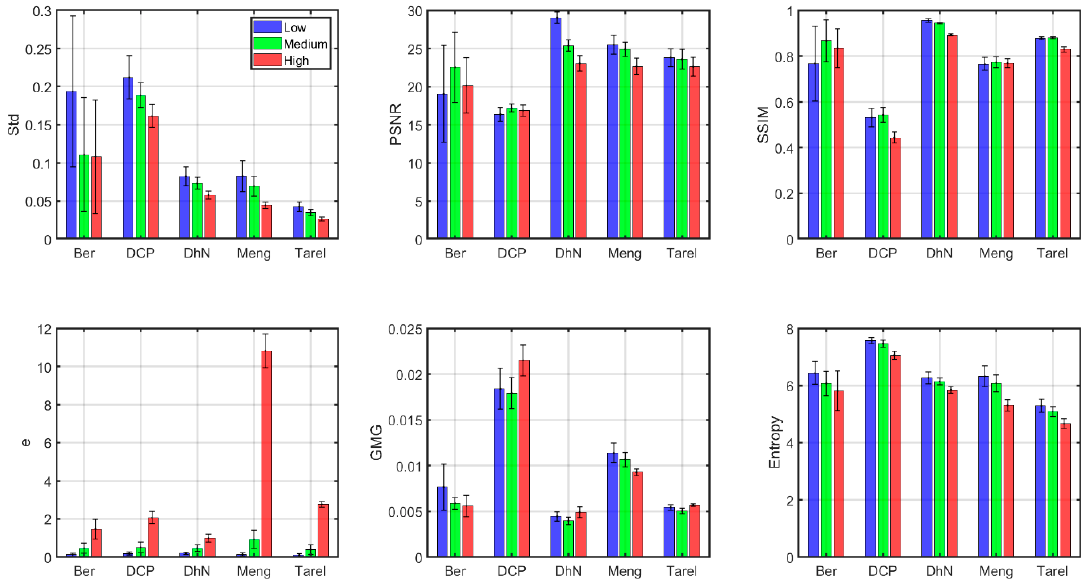
Figure 7. Quality metrics for the dehazed images (average of all wavelengths above 550 nm). Standard deviations are indicated as error bars in the figure.